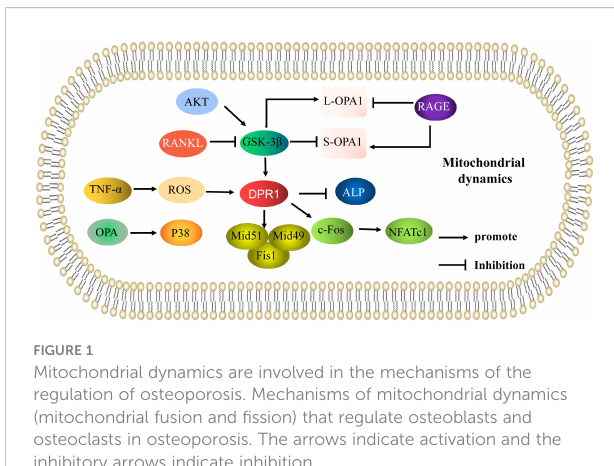
FIGURE 1 Mitochondrial dynamics are involved in the mechanisms of the regulation of osteoporosis. Mechanisms of mitochondrial dynamics (mitochondrial fusion and fi ssion) that regulate osteoblasts and osteoclasts in osteoporosis. The arrows indicate activation and the inhibitory arrows indicate